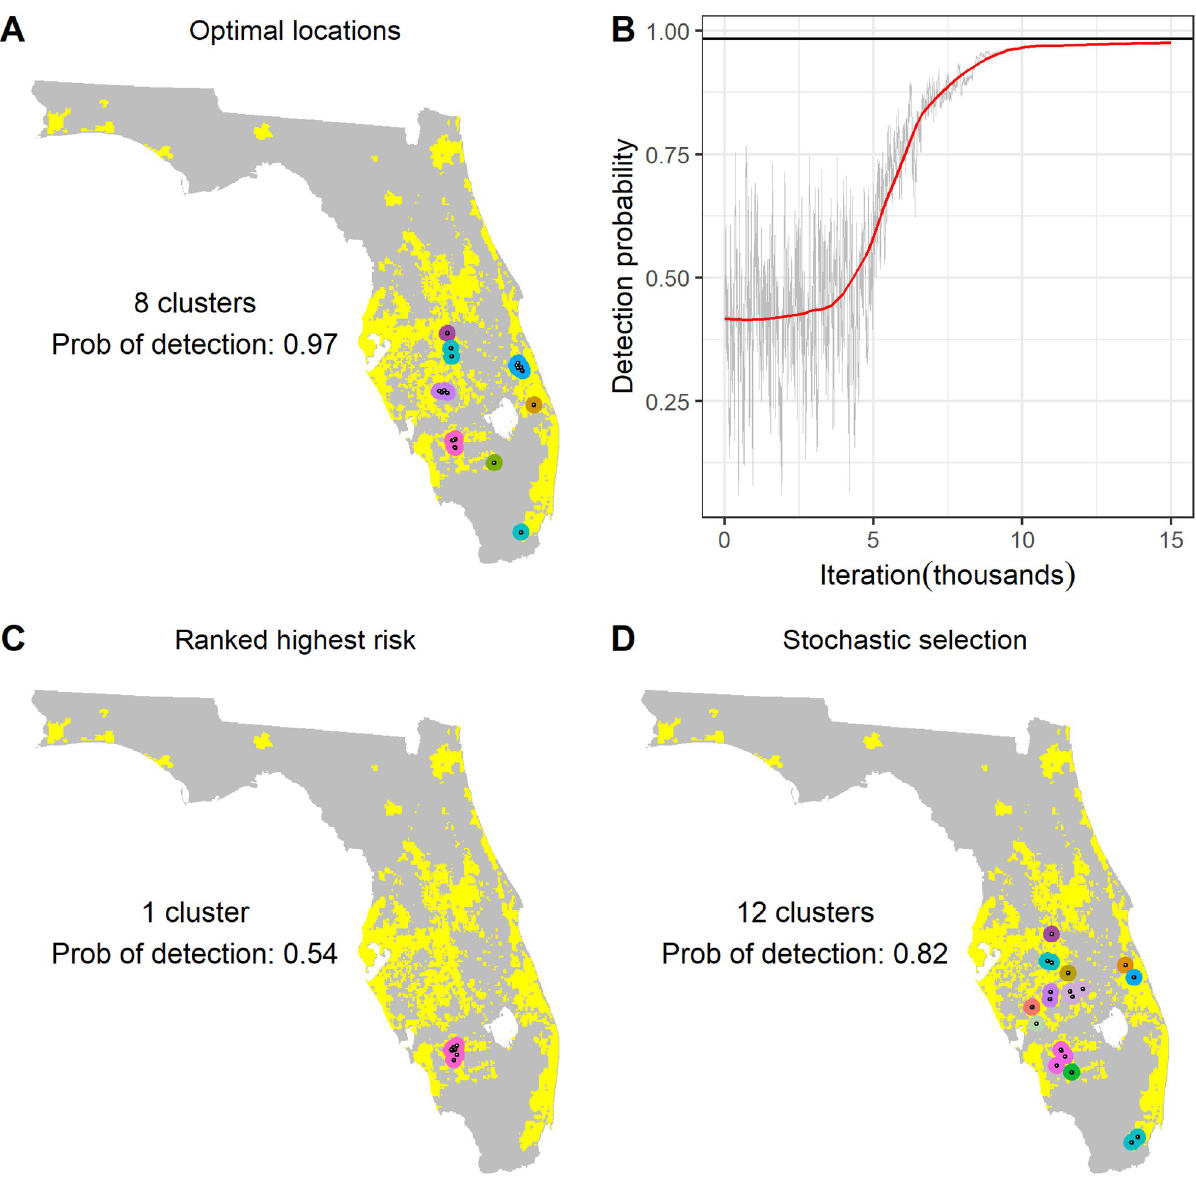
Fig 2. Arrangement of sampling sites under different selection schemes. These plots show the distribution of selected sites for 1 case of optimised selection and 2 alternative risk-based approaches based upon the mean end prevalence obtained from the simulation model. Plot A shows the sites selected to maximise the probability of detection when using simulated annealing. The progression of the detection probability over the first 15,000 iterations of the simulated annealing algorithm is shown in plot B, with the solid black line indicating the final detection probability after 100,000 iterations. Plot C shows the 20 sites with the highest mean end prevalence over all realisations, and plot D shows 1 arrangement of 20 sites selected with a probability proportional to the mean end prevalence. Clusters (defined as sites within 20 km of each other) are shown in distinct colours in plots A, C, and D. Estimates of the number of clusters and the probability of detection under the different sampling patterns are also shown. The data used to create these plots can be found at https://doi.org/10.17866/rd.salford.12759929.v1 (files ‘spatialData_baselines.csv’ and